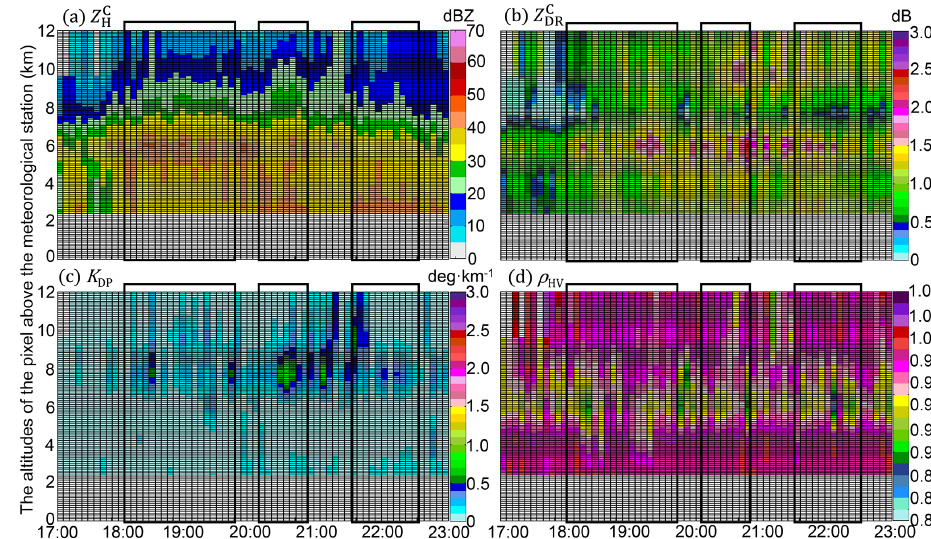
Figure 17. The same as Fig. 12 but for the XJ station between 15:00UTC, 8 August 2019, and 21:00UTC, 9 August 2019.